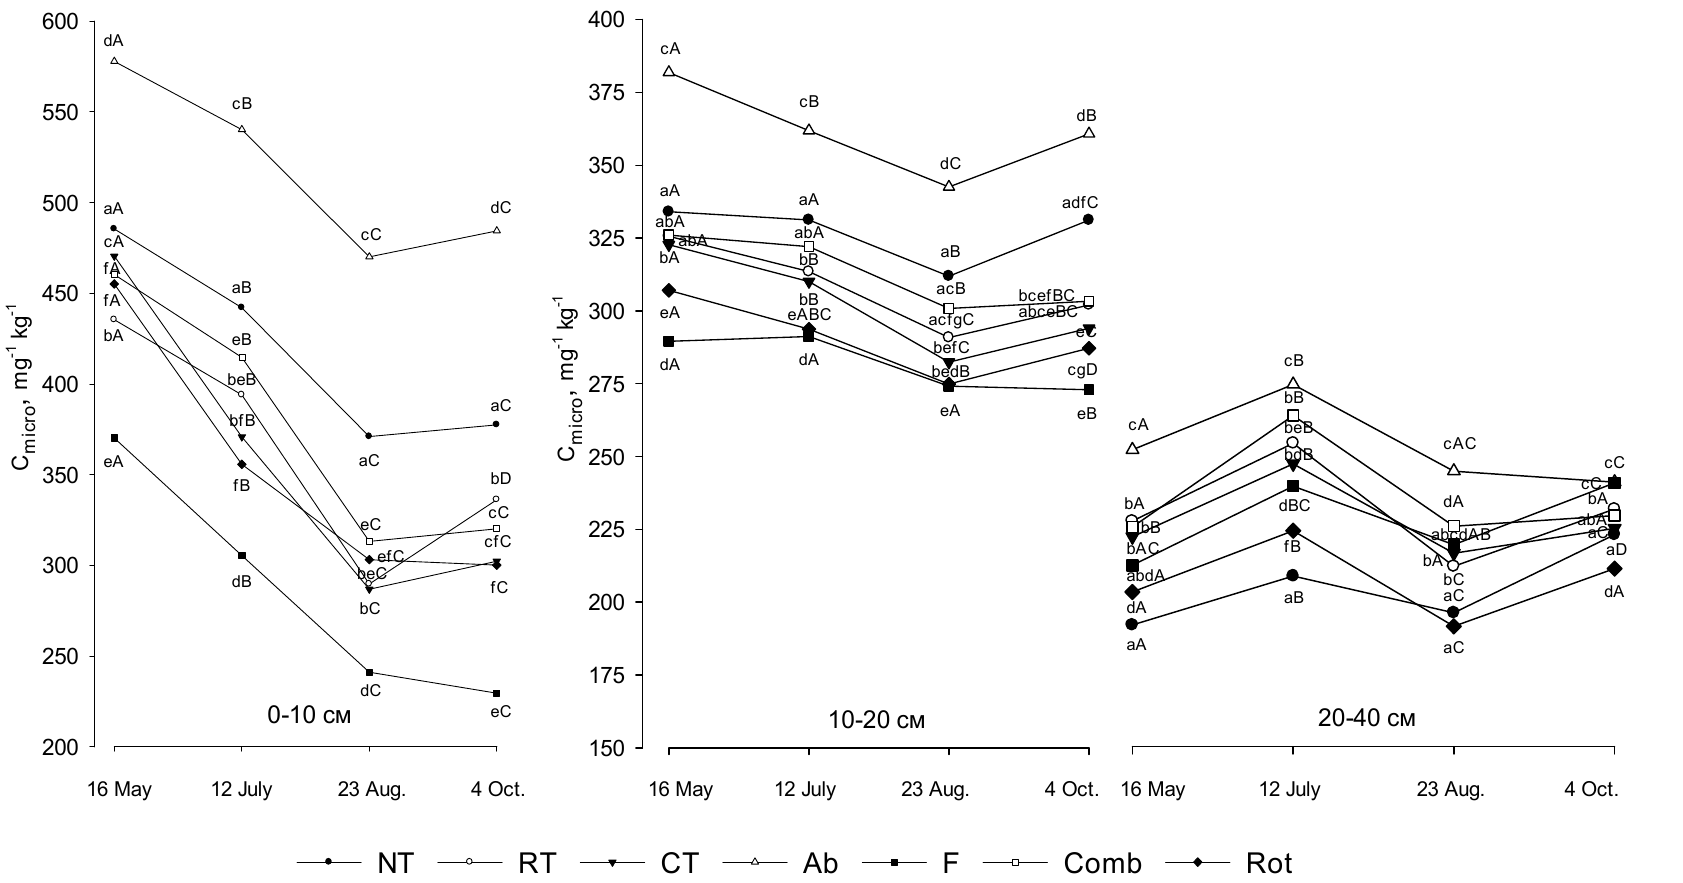
Figure 2. Seasonal dynamics of C micro in different of Mollisol layers after 9 years of use: conservation tillage (CT), no till (NT), rotary (Rot), reduced (ridge) tillage (RT), combined (Comb) tillage and fallow (F, 22 years) and abandoned field (Ab, 22 years). Average values with different lowercase letters indicate a significant difference between tillage options, and uppercase letters are a significant difference between the selection periods (HIP, α = 0.05).